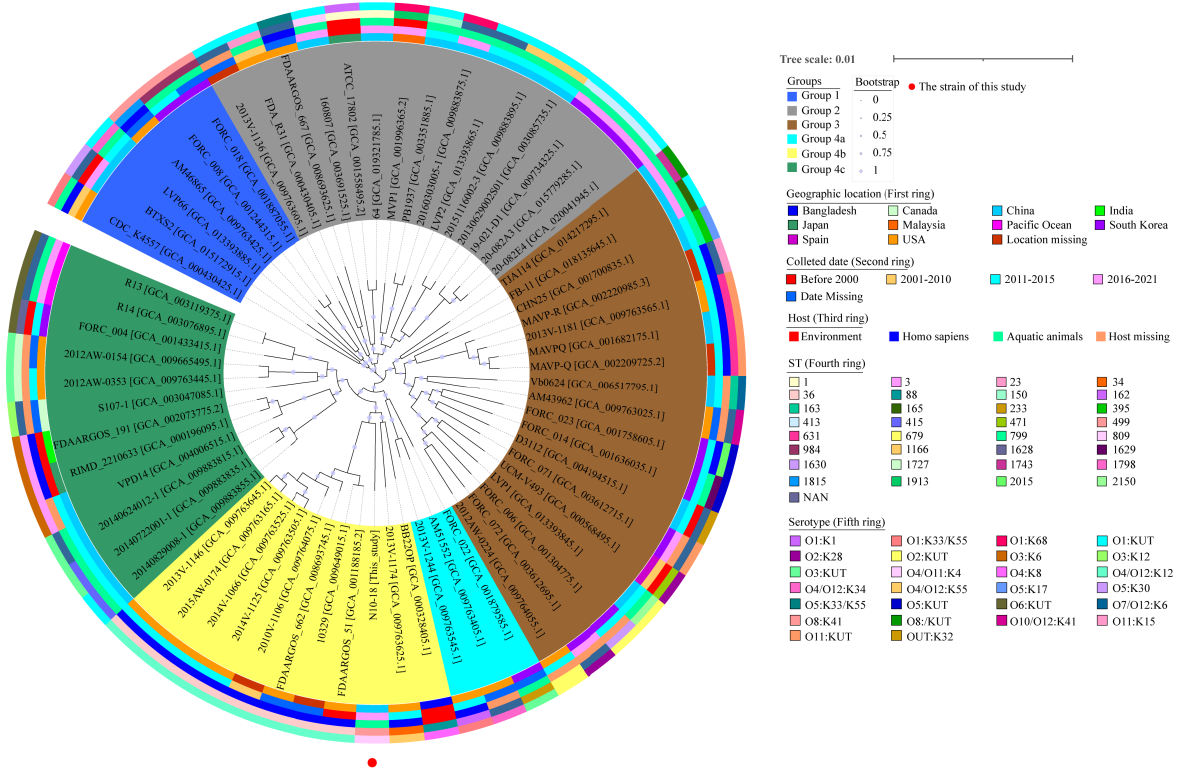
Figure 2. A phylogenetic tree construed on the basis of genome-wide homologous single-copy genes in 65 V. parahaemolyticus strains . The isolation time and location, serotypes, STs, and host information of these strains were integrated into the tree.